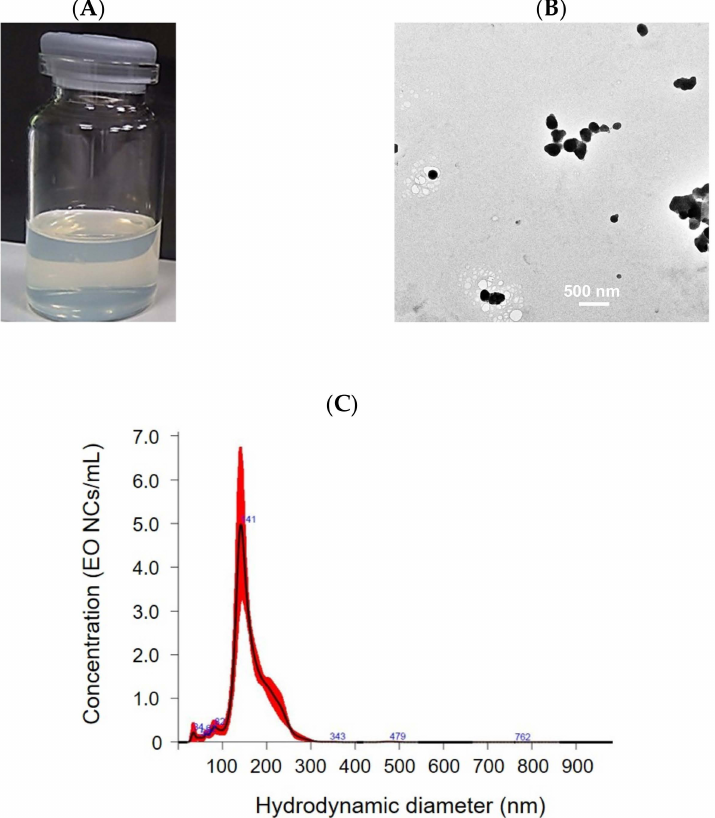
Figure 1. Characterization of EO-loaded NCs: ( A ) macroscopic appearance, ( B ) TEM images, and ( C ) size distribution.